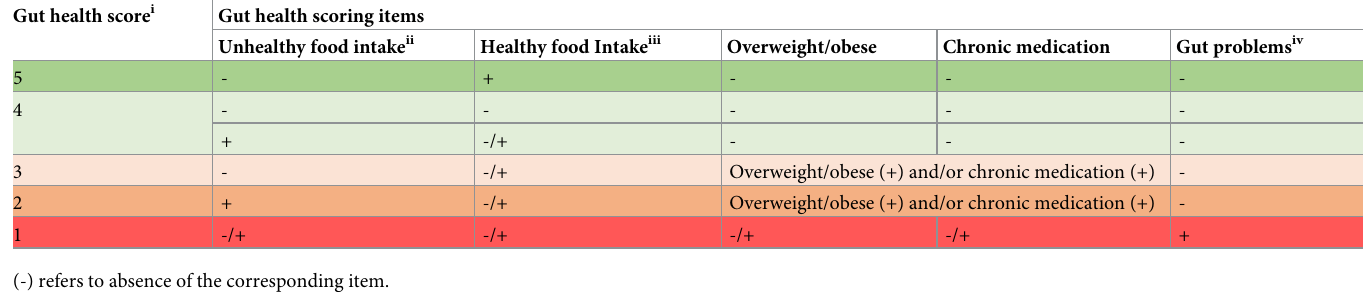
Table 1. Gut health